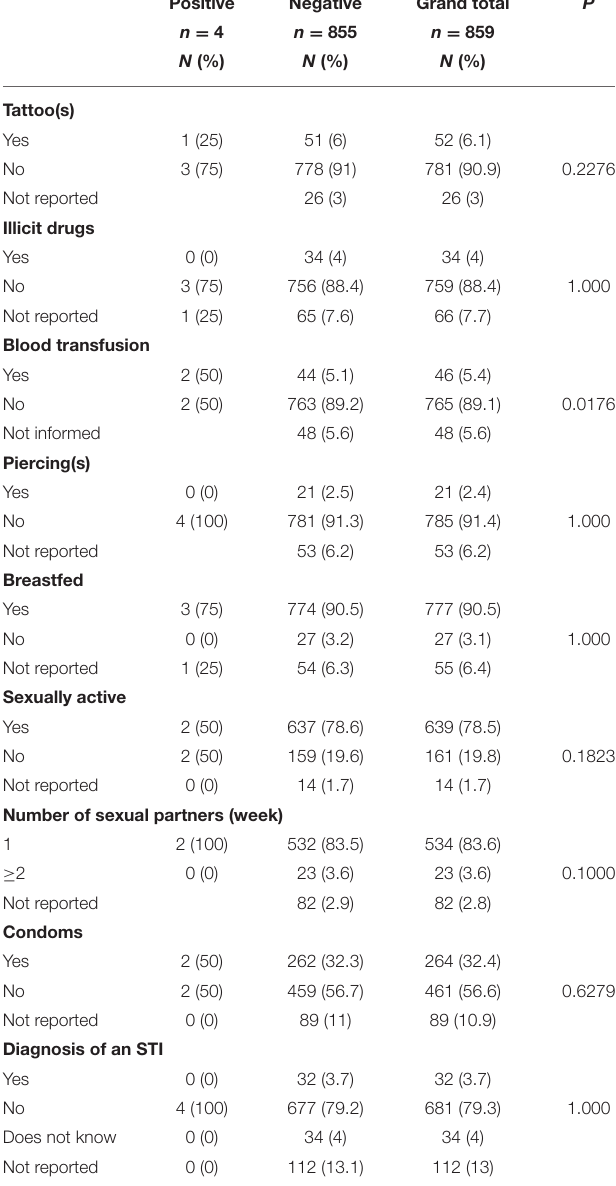
TABLE 4 | Association of HTLV-1/2 infection with behavioral risk